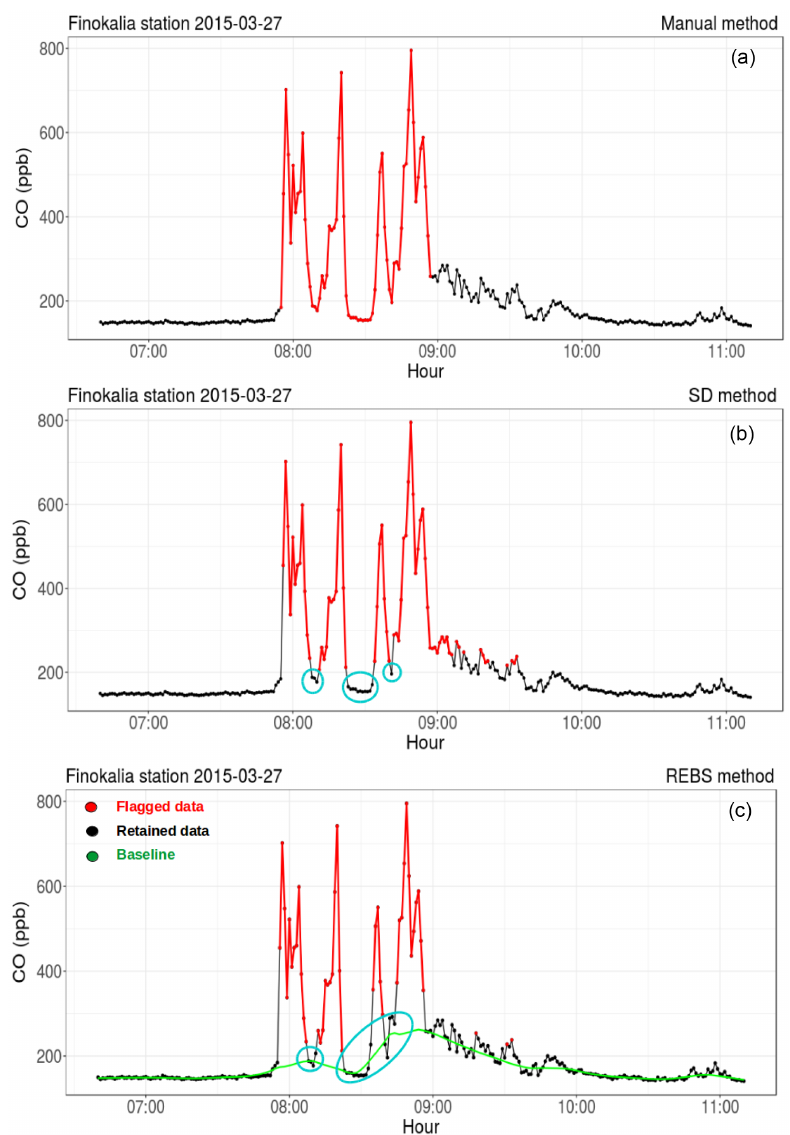
Figure 8. Example of a spike detection using manual (a) , SD (b) and REBS (c) methods during a known biomass burning event at